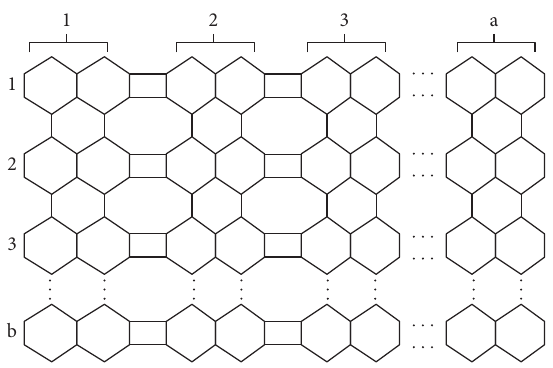
Figure 10: An H-naphthalenic nanosheet T 3 [ a,b ] . Table 10: The details of edges and types of the T 3 [ a,b ] nanosheet based on the degree of vertices. ( d , d ) with uv ∈ E ( G u v